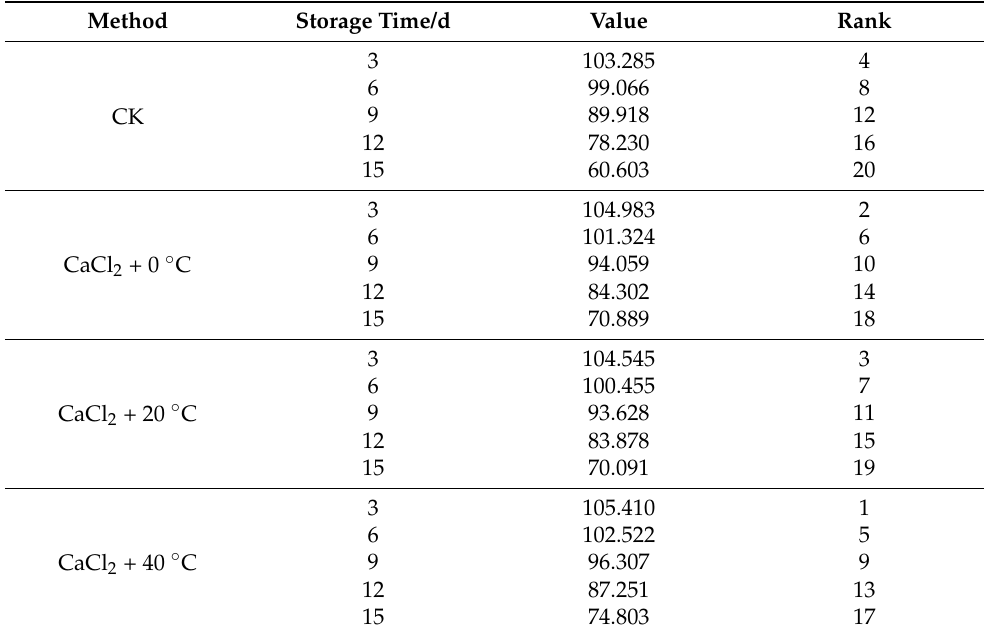
Table 7. Ranking of the comprehensive quality index values of fresh-cut “Xuebai” cauliflower florets treated with different temperatures and CaCl 2